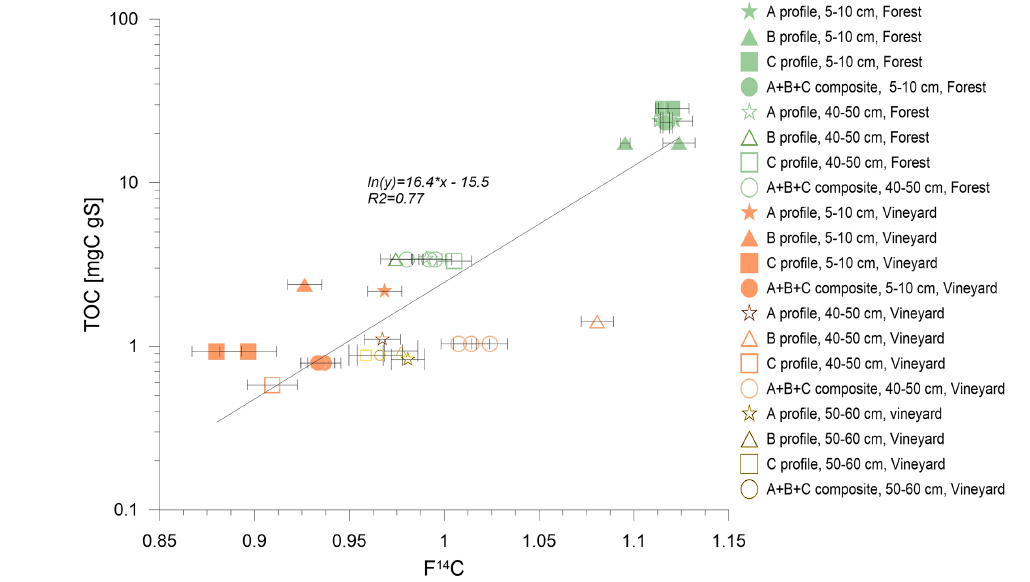
Figure D2. Variations in carbon content as a function of F 14 C. Profiles A, B, and C are represented by stars, triangles, and squares, respec- tively. These symbols are solid when they represent topsoil samples (5–10cm) and empty when they represent deep samples (40–50cm). Soil samples obtained under the forest are green and those under vines are orange. The error bars represent the analytical error. The TOC values were higher with younger F 14 C (usually topsoil samples), and R 2 = 0.77. Under the vineyard, plowing had eliminated the young carbon pools.